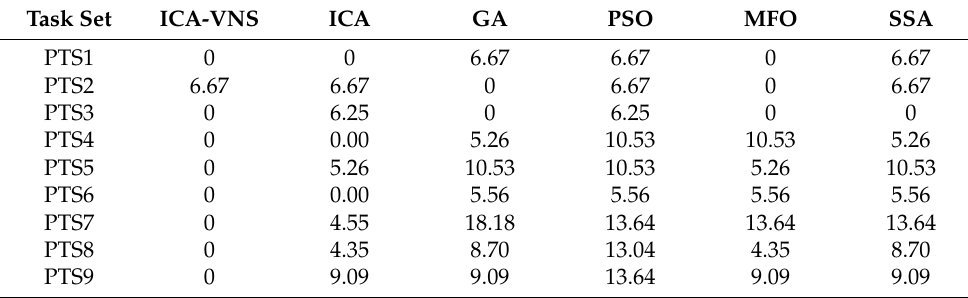
Table 9. The RE value comparison of six algorithms.